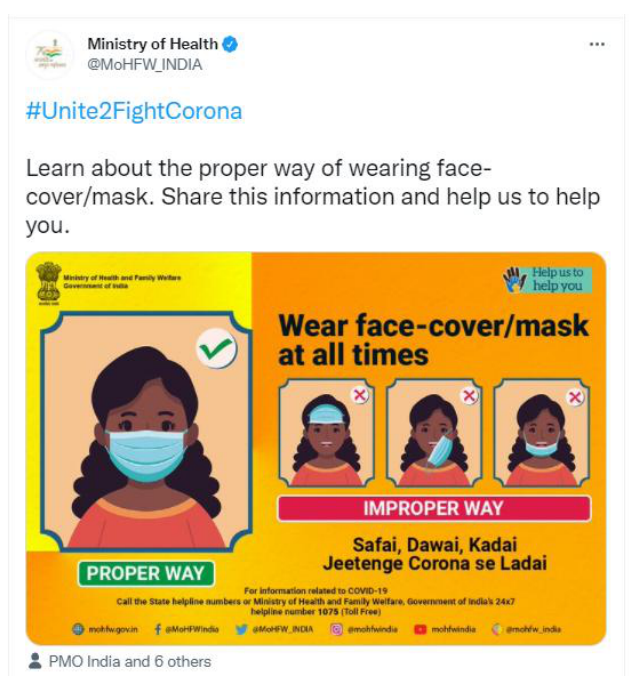
Image 4: A Picture Posted on Twitter by the Ministry of Health to Teach People How to Properly Wear Masks (Source: Ministry of Health